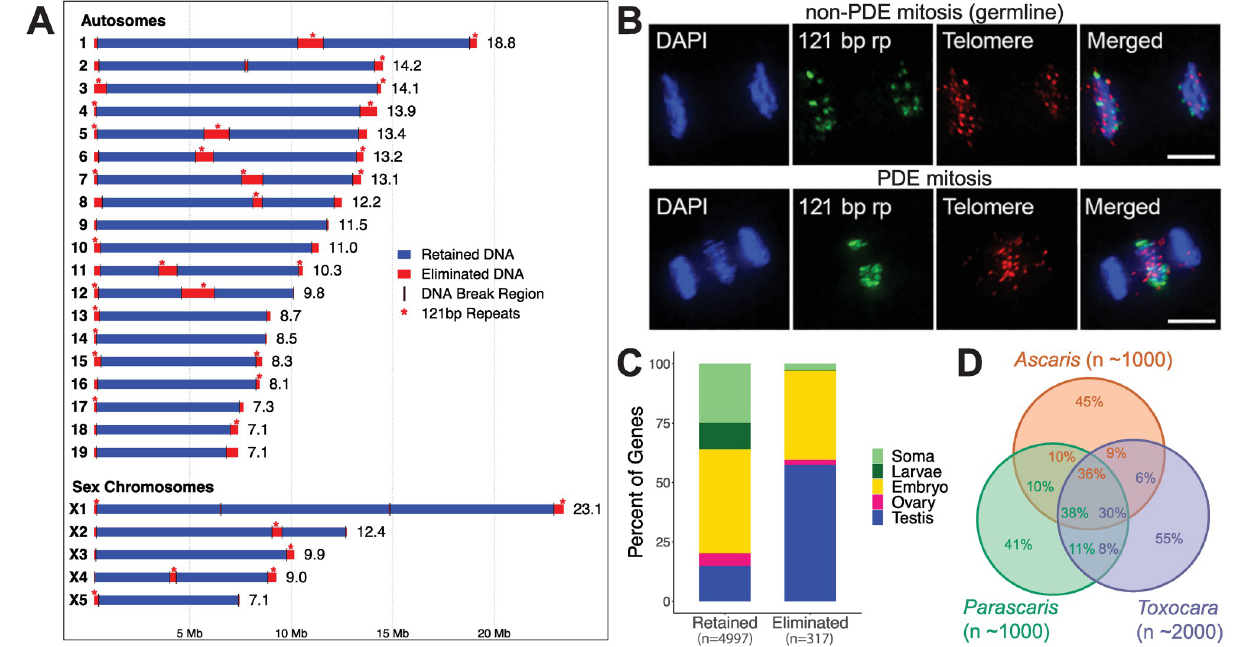
Fig 2. Genetic material lost during PDE. ( A ) A linear presentation of Ascaris germline chromosomes. All chromosome ends and 12 internal regions are eliminated (shown in red). Many larger chromosomes have internally eliminated sequences which split them into smaller chromosomes in the soma. Eliminated regions containing 121-bp repeats are marked with a red � . Figure adapted from [6]. ( B ) FISH of 121-bp repeats and telomeric sequences. Top: anaphase in a germline embryo undergoing non-PDE mitosis, with telomeres and 121-bp repeats passing to daughter nuclei. Bottom: anaphase of a PDE mitosis showing 121-bp repeats and telomeres are left at the metaphase plate. ( C ) Eliminated genes are highly enriched with testis and embryo-expressed genes. Shown are changes of the proportion (in percentage, y-axis) of tissue-specific genes in retained and eliminated DNA (x- axis). ( D ) Conservation of eliminated genes among Ascaris , Parascaris , and Toxocara . About 36% of genes eliminated in Ascaris have their orthologous genes eliminated in Parascaris and Toxocara . These genes tend to have enriched expression in the testis. Figure adapted from [6].